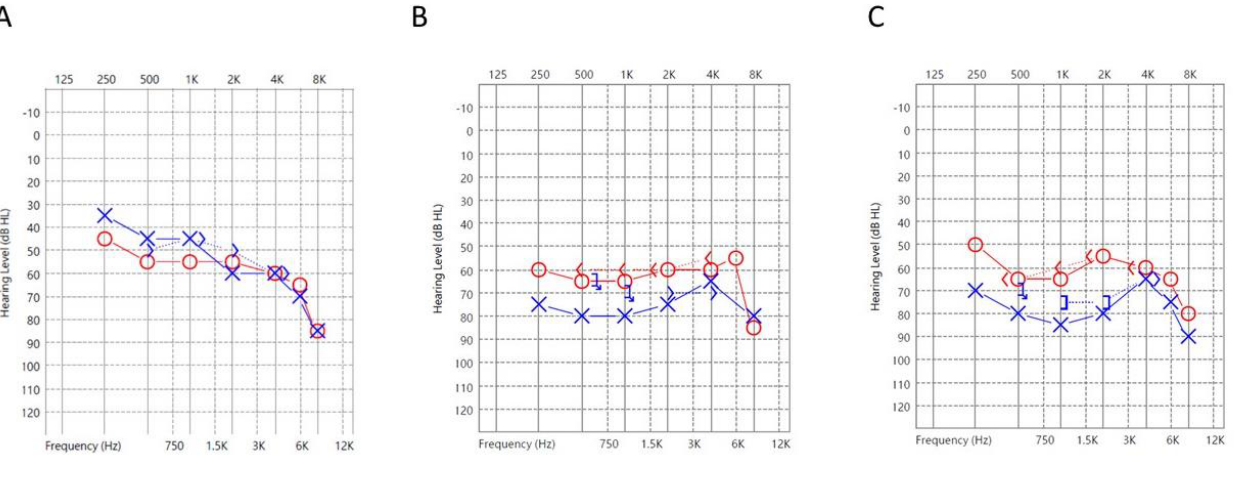
Figure 3. Audiograms of Patient 3 with positive PCR: ( A ) 6 weeks before presentation; ( B ) at presentation; ( C ) 2 months after treatment. (O: Unmasked air conduction thresholds in the right ear; X: Unmasked air conduction in the left ear; <: Unmasked bone conduction in the right ear; >: Unmasked bone conduction in the left ear; ]: Masked bone conduction in the left ear; Arrows (on any symbol): No